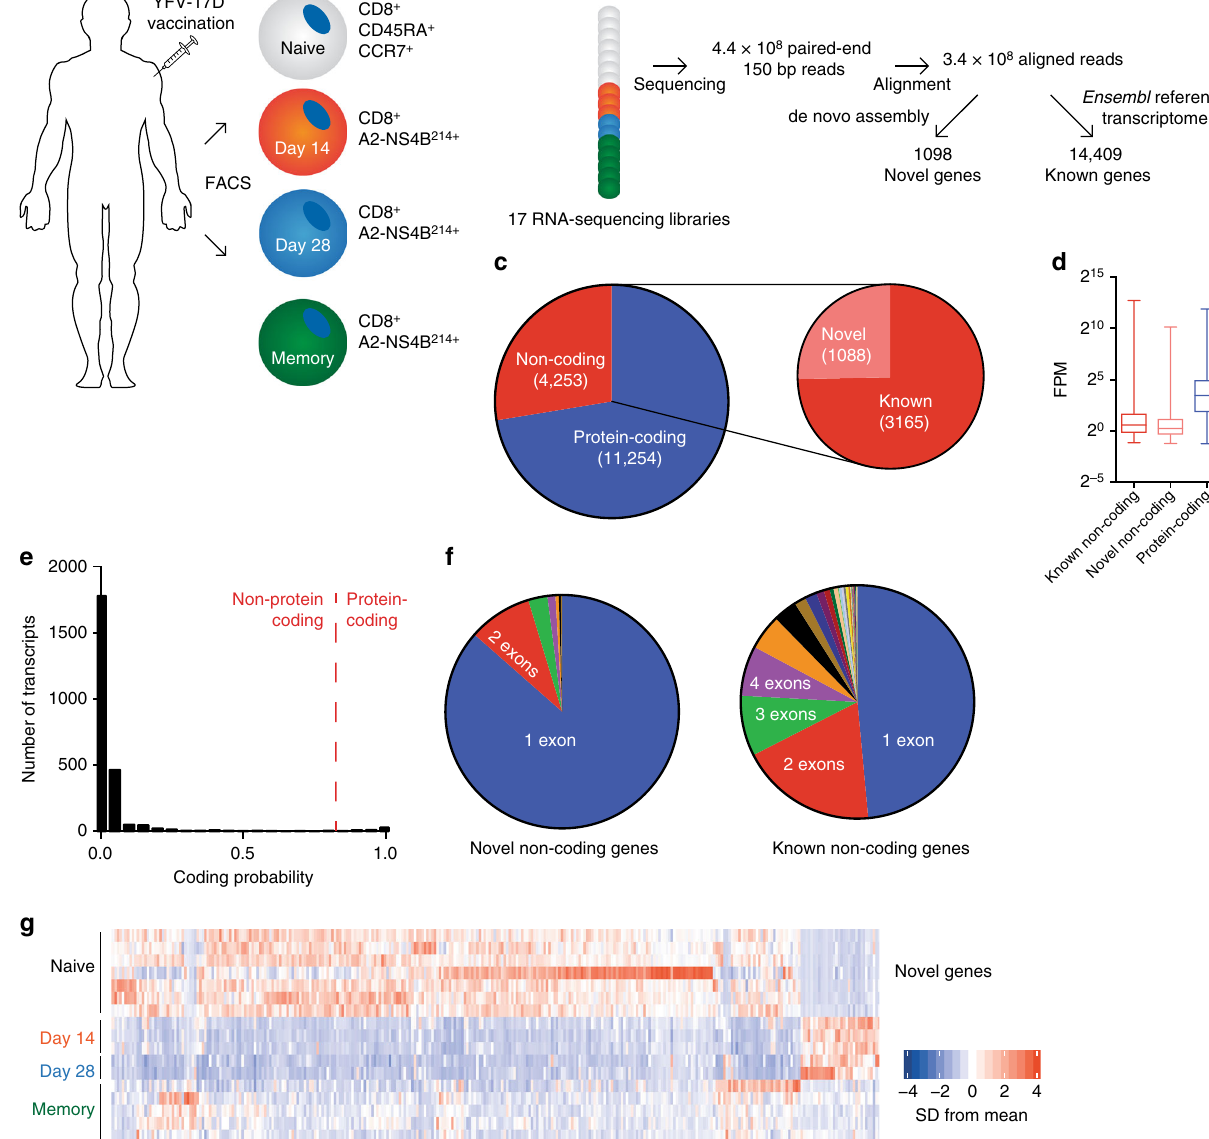
(Fig. 3a – c), naive, effector, and memory CD8 + T cells formed three distinct clusters in all principal component analyses (Fig. 6a – c). Post-infection day 14 and 28 cells were not readily differentiated by PCA, as expected by the use of the bulk antigen- speci fi c population. Once again, PCA performed on both known noncoding genes and the novel noncoding genes identi fi ed here yielded similar grouping as the exclusive use of protein-coding